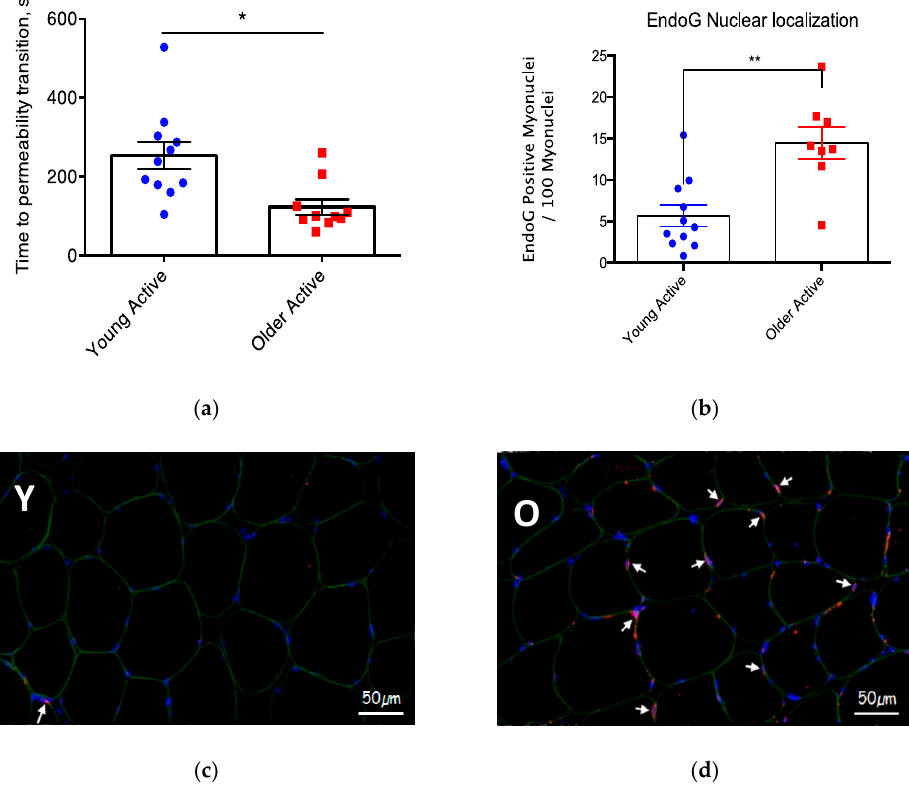
Figure 4. Mitochondria in aging skeletal muscle exhibit a sensitization to permeability transition in response to a Ca 2 + challenge (represented by a shorter time to permeability transition; panel ( a )), and this is associated with nuclear translocation of the mitochondrial-derived protein, EndoG (panel ( b )). Filled blue circles = young physically active adult; filled red square = older physically active adult. Images show a human vastus lateralis muscle cross-section from a young physically active (Y; panel ( c )) and an older physically active (O; panel ( d )) man immunofluorescently labeled with primary antibodies against dystrophin (green), DAPI (blue), and EndoG (red). Arrows depict nuclei containing EndoG. * and ** p < 0.05 versus Young Active. Figures shown are adapted from [32].